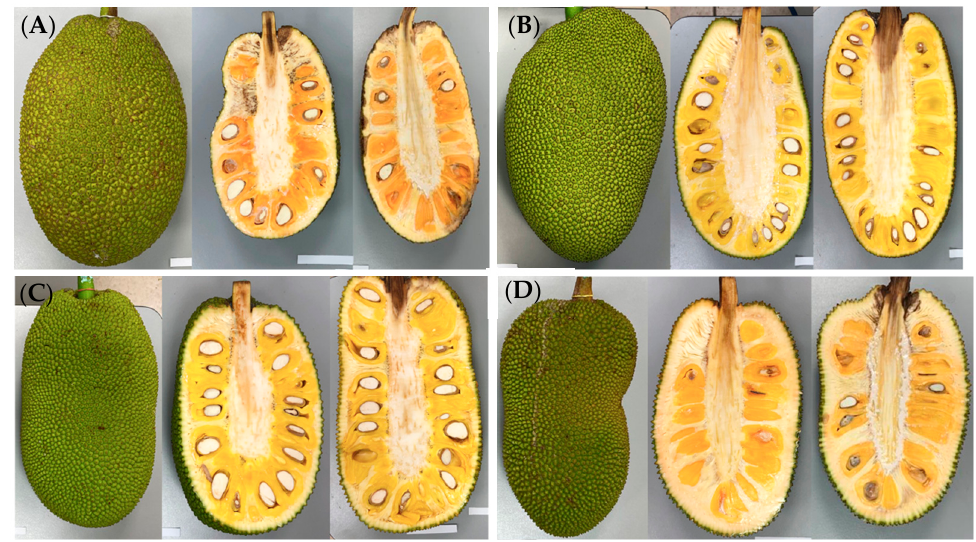
Figure 2. Cross-section of the different jackfruit genotypes showing morphological aspect after five days of storage. ( A ): Agüitada genotype, ( B ): Rumina genotype, ( C ): Licenciada genotype, ( D ): Virtud genotype; Storage condition: 25 °C, 90 % relative humidity).